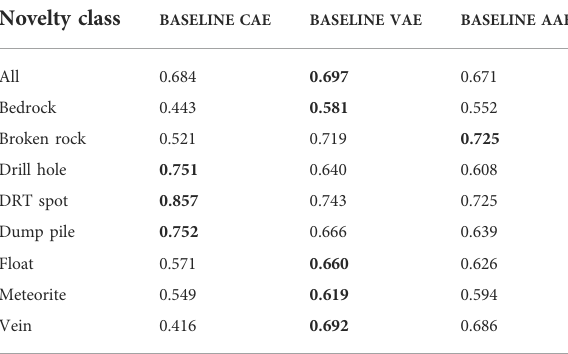
TABLE 3 Class-wise ROC AUCs for BASELINE models trained on curiosity